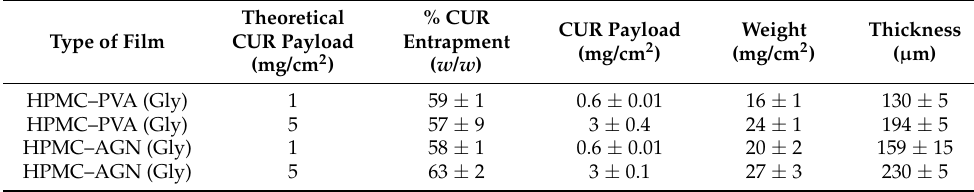
Table 2. Physical characteristics of the HPMC–PVA (Gly) and HPMC–AGN (Gly) films ( n = 10, mean ±